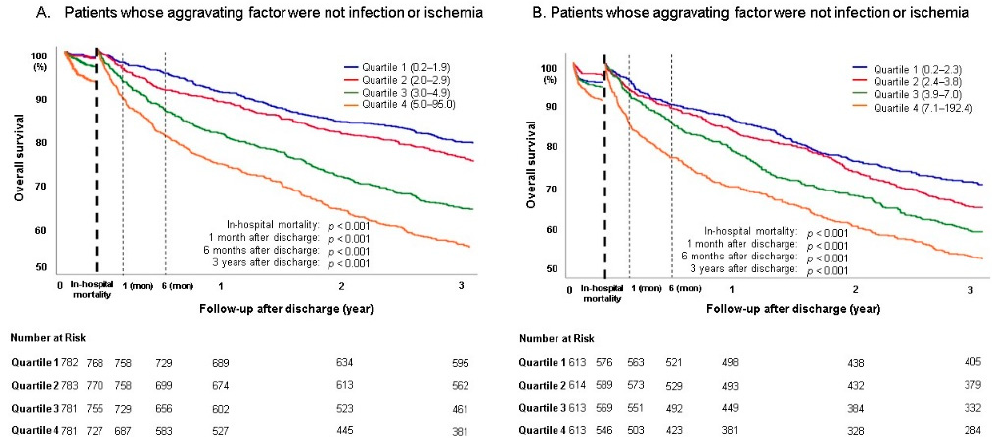
Figure 2. Overall in-hosptial mortality and 3-year survival after discharge of HF patients subgroup analysis by aggravating factor. ( A ) Quartile 1 (0.2–1.9), Quartile 2 (2.0–2.9), Quartile 3 (3.0–4.9), Quartile 4 (5.0–95.0); ( B ) Quartile 1 (0.2–2.3), Quartile 2 (2.4–3.8), Quartile 3 (3.9–7.0), Quartile 4 (7.1–192.4). Table 3. Baseline clinical characteristics of HF patients whose aggravating factor were not infection or ischemia stratified by quartiles of neutrophil to lymphocyte ratio at admission. HF, heart failure; BMI, body mass index; BP, blood pressure; NYHA, New York Heart Association; LVEF, left ventricular ejection fraction; HF, heart failure; AF, atrial fibrillation; WBC, white blood cells; BUN; blood urea nitrogen; Cr, creatinine; eGFR, estimated glomerular filtration rate; BNP, brain natriuretic peptide; NT-proBNP, n-terminal brain natriuretic peptide; ACEi, angiotensin-converting-enzyme inhibitor; ARB, angiotensin II receptor blocker; Tx., therapy; TPL, transplantation.